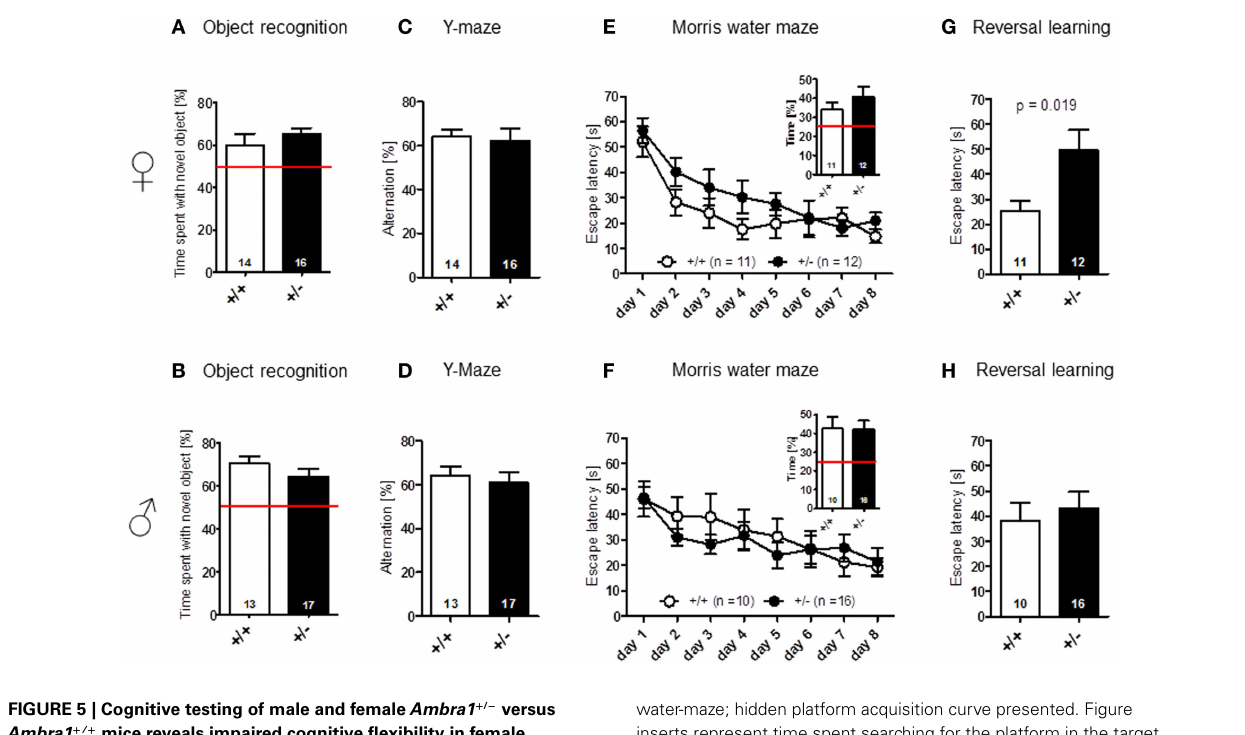
FIGURE 5 | Cognitive testing of male and female Ambra1 + / − versus Ambra1 + / + mice reveals impaired cognitive flexibility in female Ambra1 + / − mice .The upper row presents results for female, the lower row for male mice. (A,B) Novel object recognition, no-delay task. (C,D) Spatial alternation inY-maze. (E,F) Spatial learning in the Morris